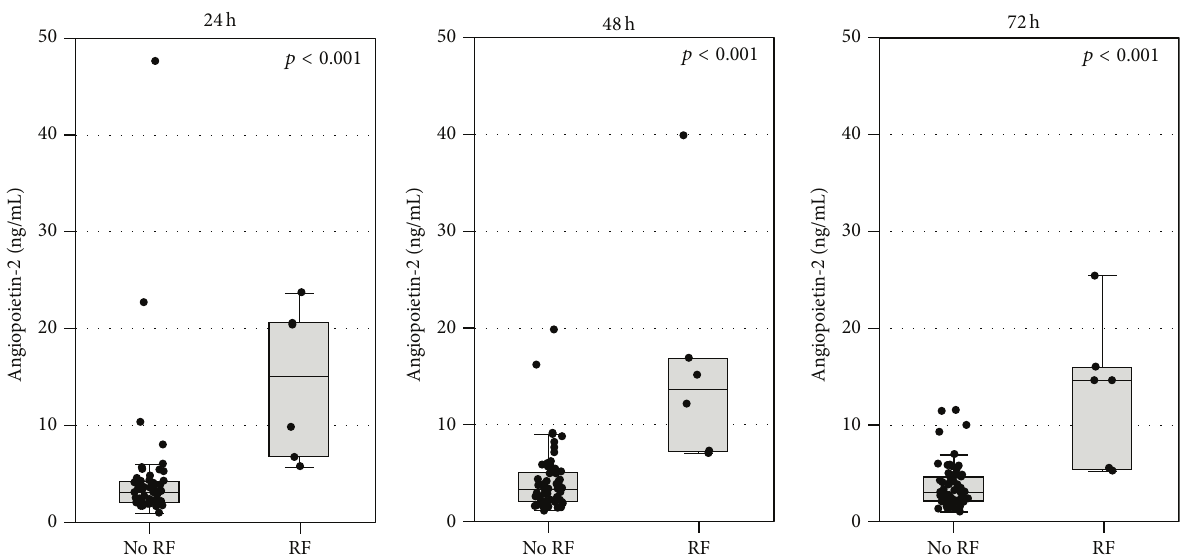
Figure 2: Serum angiopoietin-2 concentrations at 24, 48, and 72 hours after the onset of symptoms in AP patients without renal failure (no RF) and with renal failure (RF) diagnosed according to the modified Marshall scoring system. Data are shown as median, 25th–75th percentile (boxes), and nonoutlier range (whiskers); the points represent raw